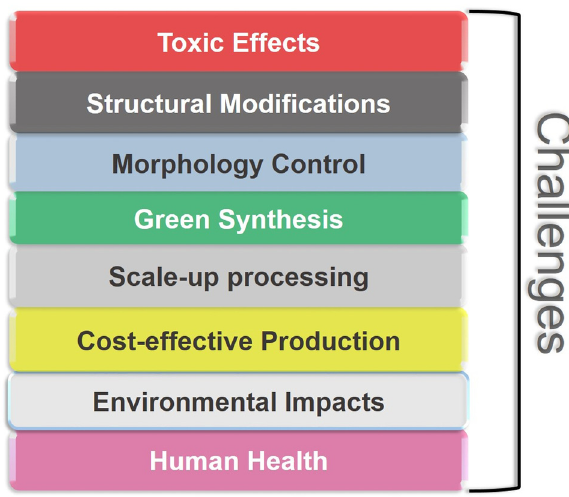
Figure 11: Key challenges related to waste - generated graphene nanocomposites for future